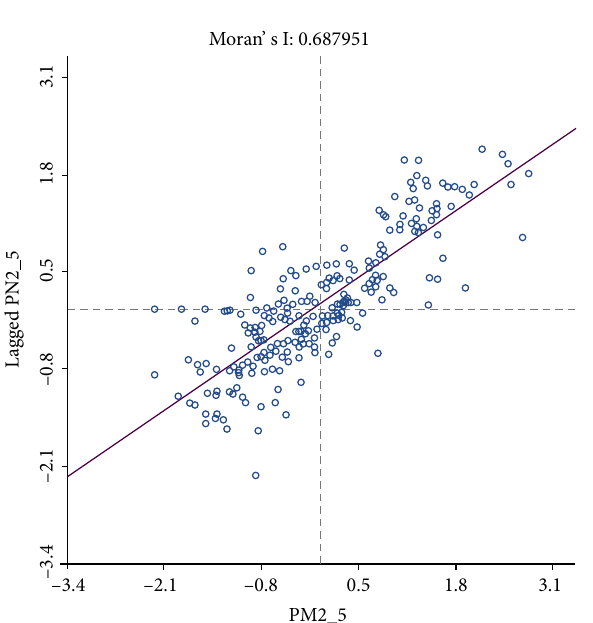
concentrations. 2.5